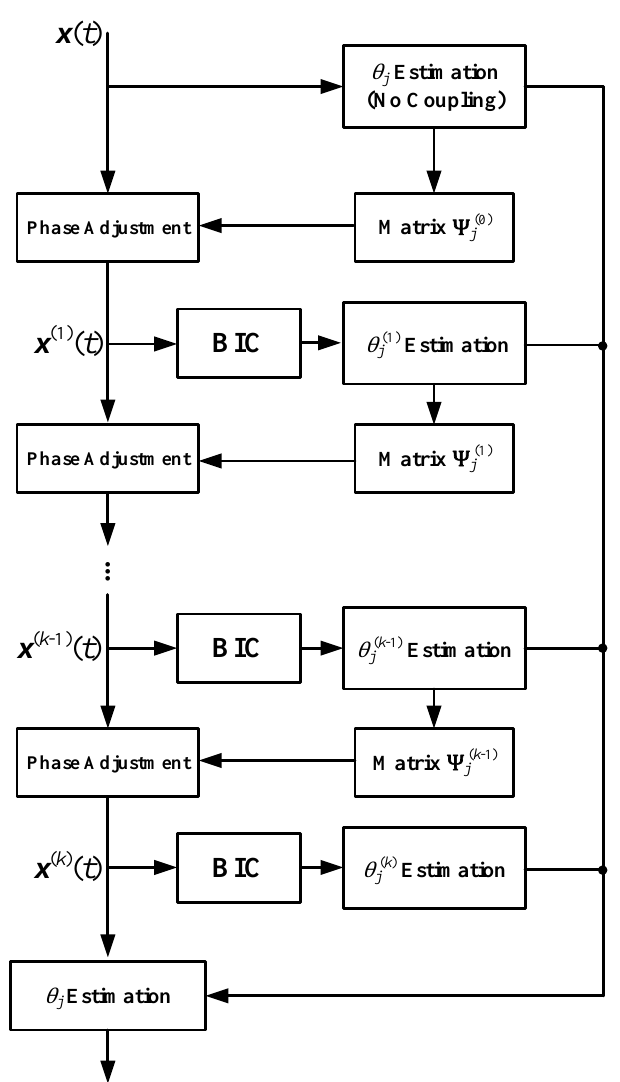
Figure 4. Flow chart corresponding to the IFOCE-FC method, where BIC denotes the module of biologically inspired